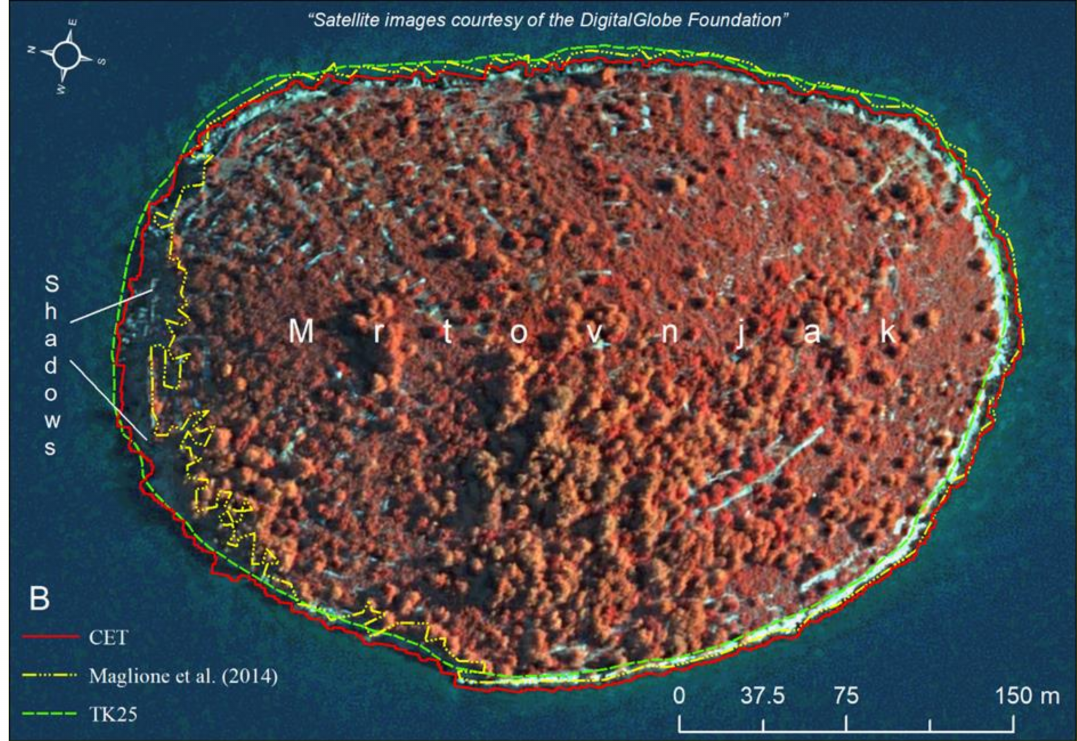
Figure 13. Successful automated extraction of coastline over significantly shaded